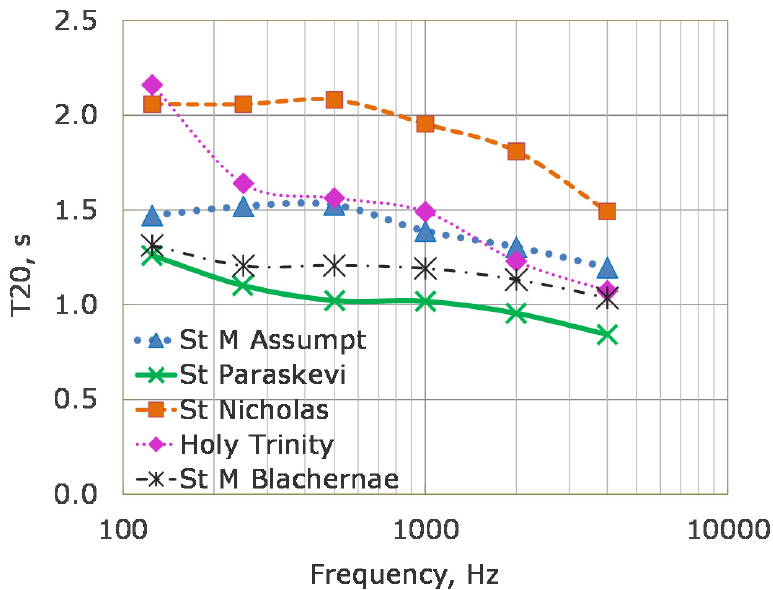
Figure 14. Measured values of reverberation time (T 20 ).